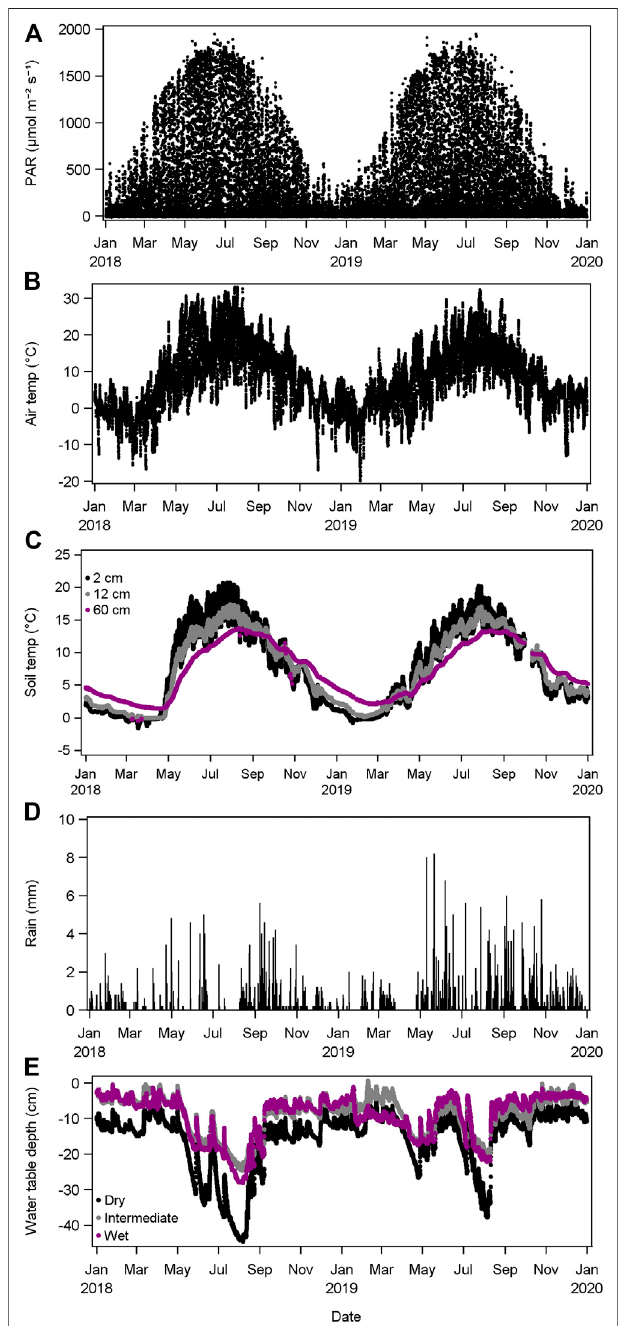
FIGURE 7 | Environmental variables measured at the study site during 2018 – 2019. (A) Photosynthetically active radiation; (B) air temperature; (C) Soil temperature at 2 cm, 12 cm and 60 cm; (D) rainfall; (E) water table depth measured at three locations.